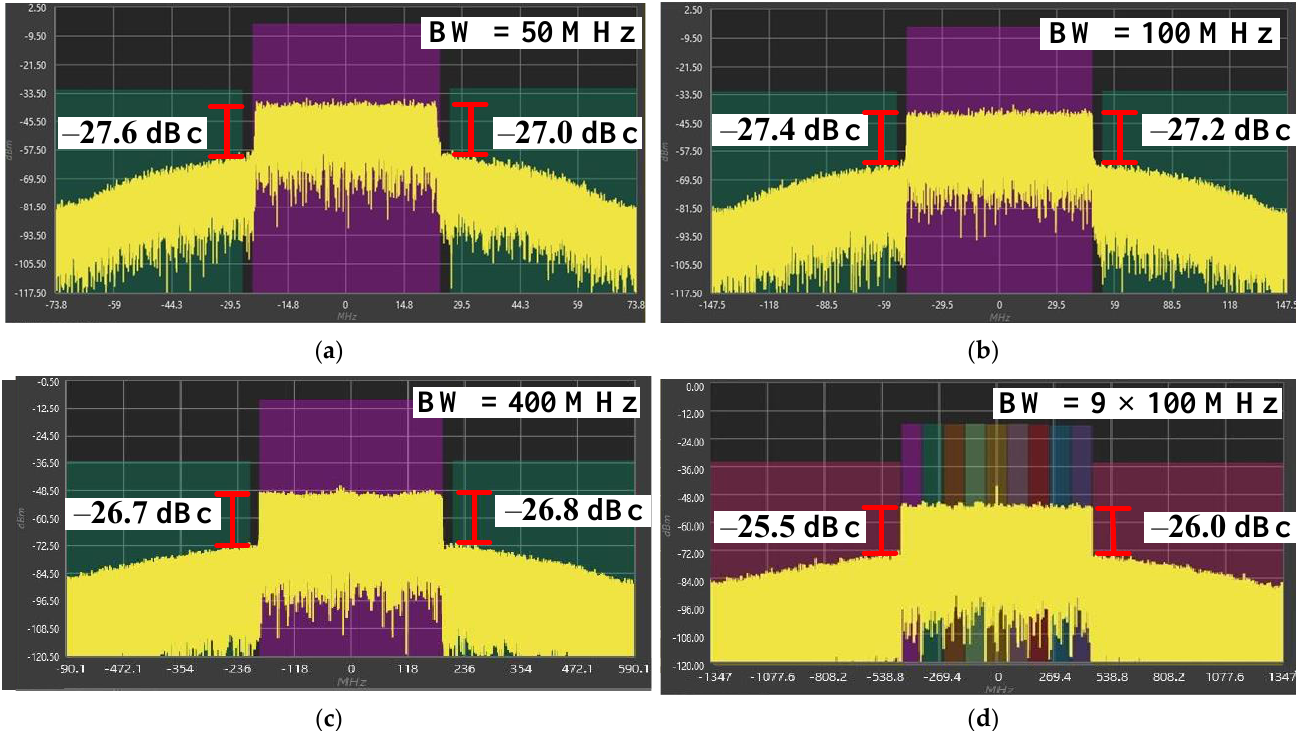
Figure 7. ACLR measurements of the broadband single-ended GaN PA at 24 GHz using a ( a ) 50 MHz, ( b ) 100 MHz, ( c ) 400 MHz, and ( d ) 9 × 100 MHz 256-QAM 5G NR signal with PAPR = 8 dB.